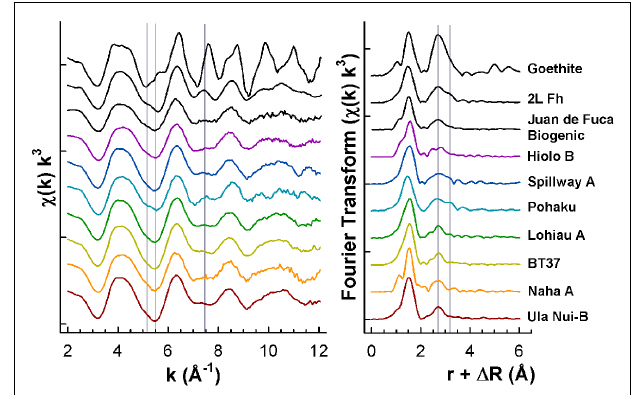
FIGURE 1 | Summary of Fe K-edge EXAFS spectra and Fourier Transform data (magnitude only) for seven Loihi Seamount mats and three reference Fe